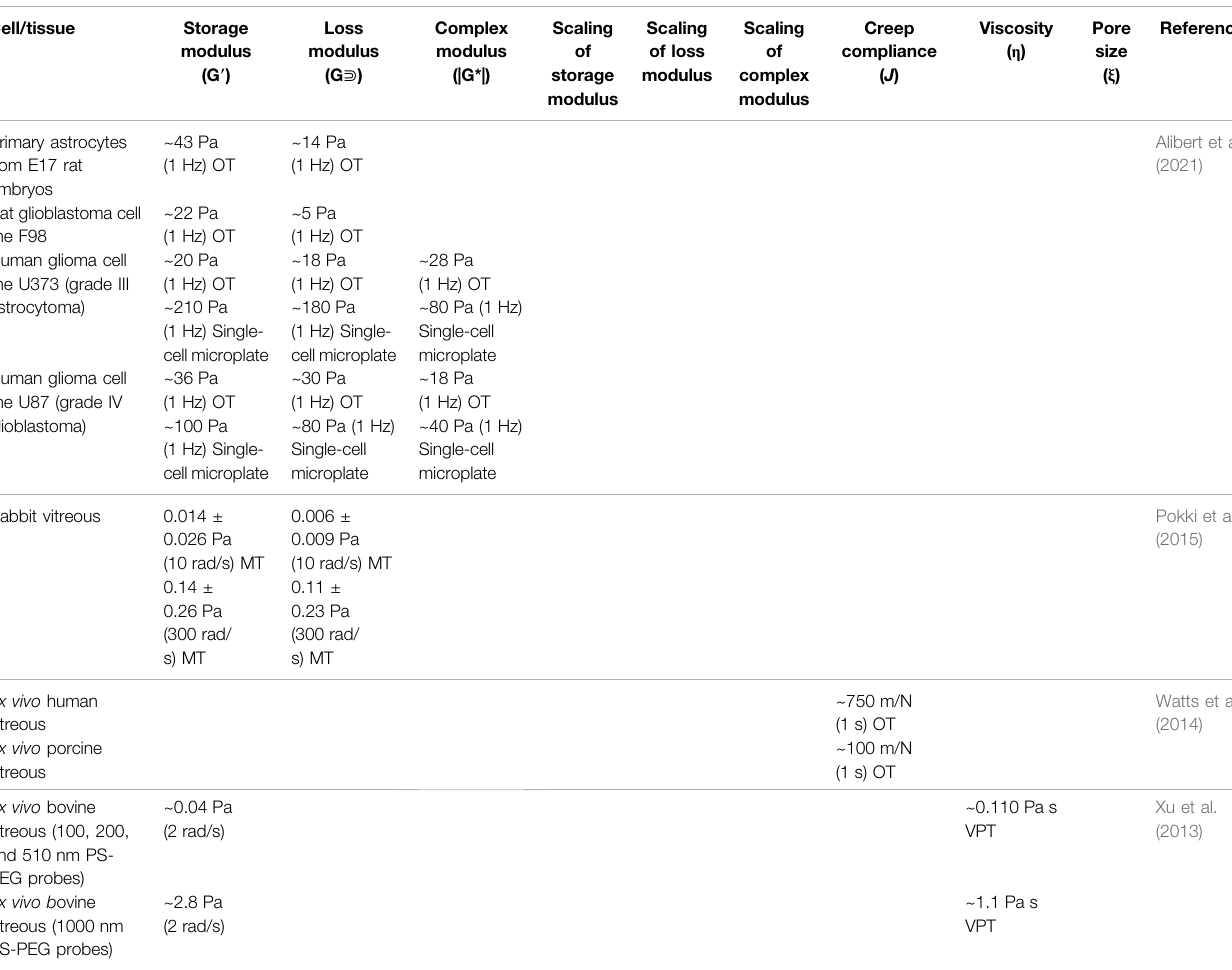
TABLE 4 | Microrheological properties of mammalian cells and tissue of the nervous system measured by various microrheological techniques. Cell/tissue